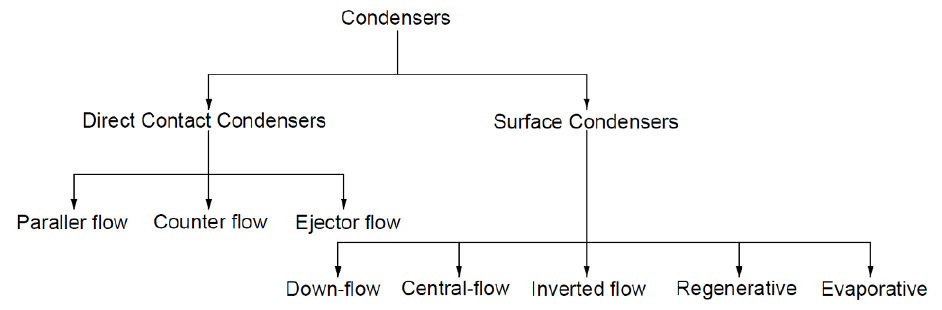
Figure 1. Classification of condensers.